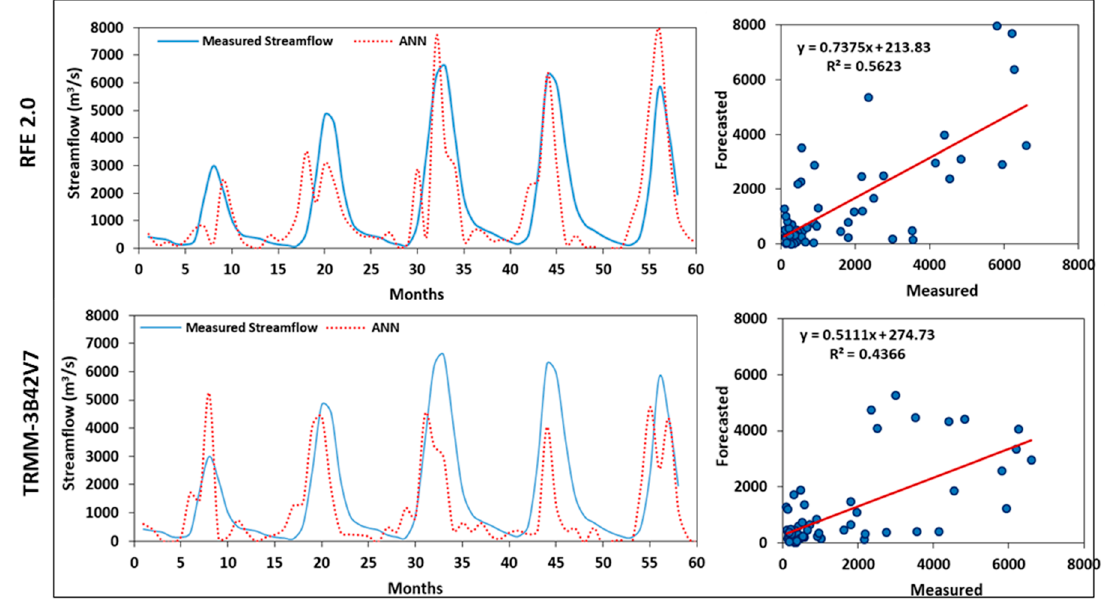
Figure 10. ANN test results of the simulated monthly streamflow at El Diem station based on TRMM-3B42V7 and RFE 2.0 data.